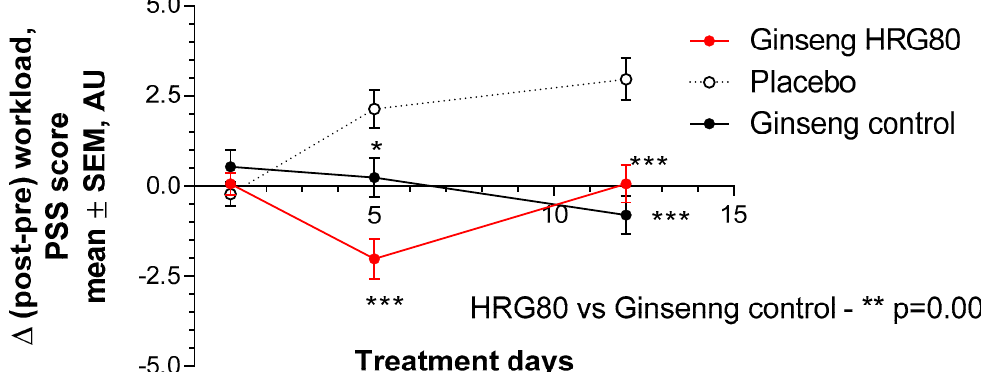
Figure 3. Change of total perceived-stress-scale (PSS) score from baseline during two weeks of treatment. Change in perceived stress with time at Days 0, 1, 5, and 12 in placebo, ginseng HRG80, and ginseng control treatment groups. Significance of changes shown by symbols * p < 0.05, ** p < 0.01, *** p < 0.001; ns, not significant. Between-group change comparison over time showed significant difference between ginseng HRG80 and ginseng control treatments ( p = 0.0004, n = 50 in each group), ginseng HRG80, and placebo treatments, but no significant difference between positive and negative controls.